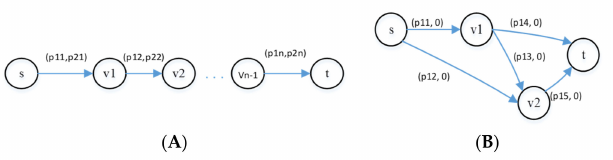
Figure 18. Special cases of the combination problems using multi-stage graph. ( A ) a system with two machines. ( B ) the reduced problem to the shortest path